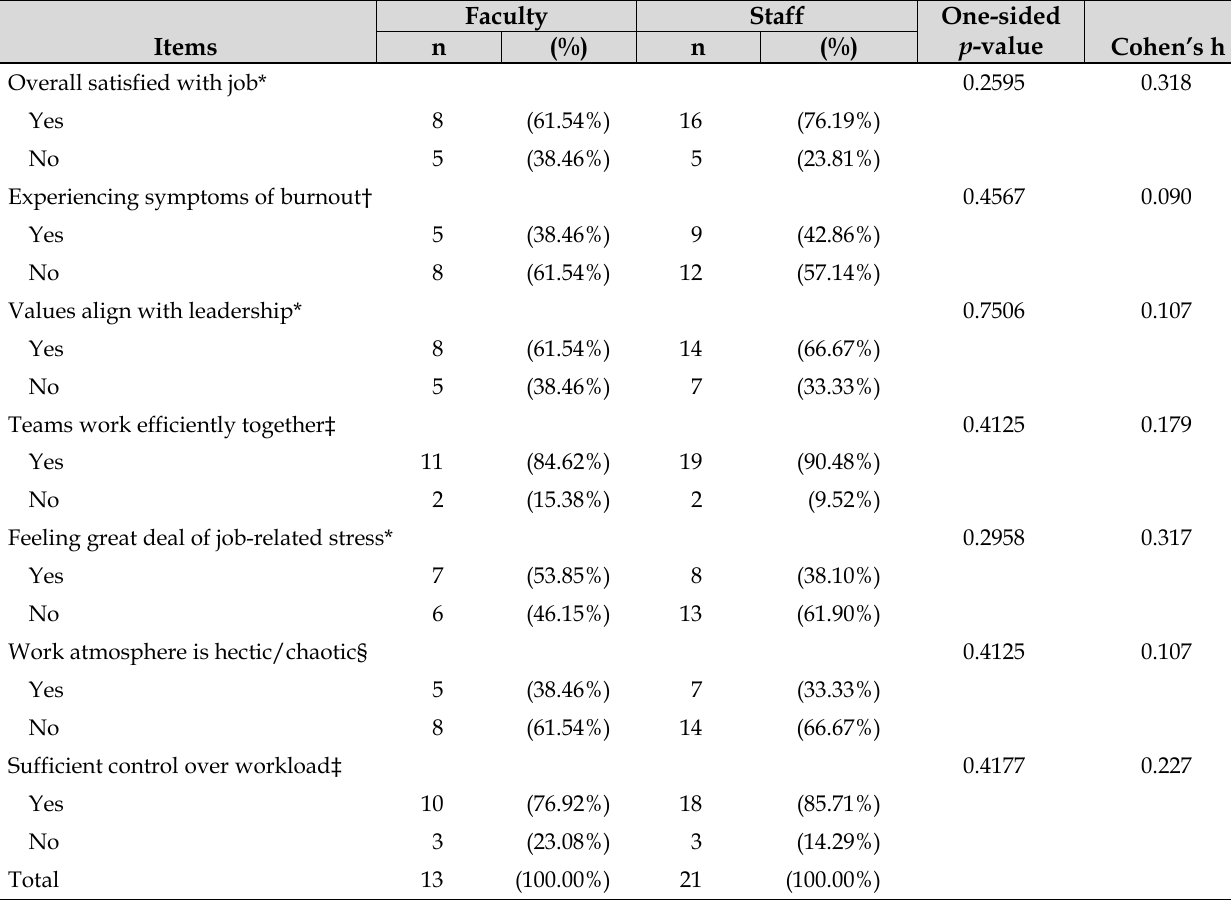
Table 4 Comparison of AMA Mini-Z items between library faculty and staff in 2018 Faculty